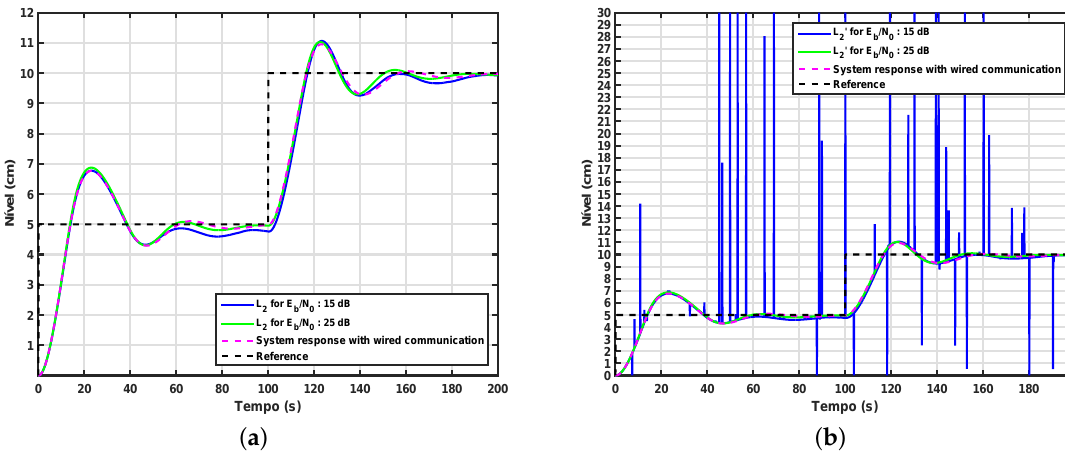
Figure 12. ( a ) System response with adaptive wavelet coding; ( b ) signal received by the controller in a system with adaptive wavelet